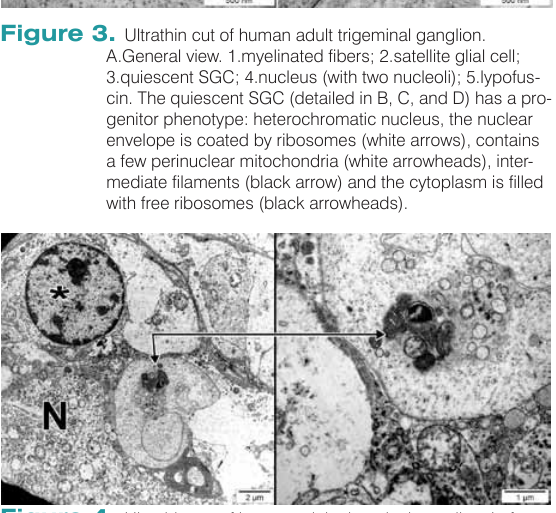
Figure 1. Semithin cut of a human adult trigeminal ganglion. Toluidine blue staining. Blood vessels (bv) are indicated. Neurons (N) are encapsulated by satellite glial cells with euchromatic nuclei (arrows) and by smaller cells with heterochromatic nuclei (arrowheads).